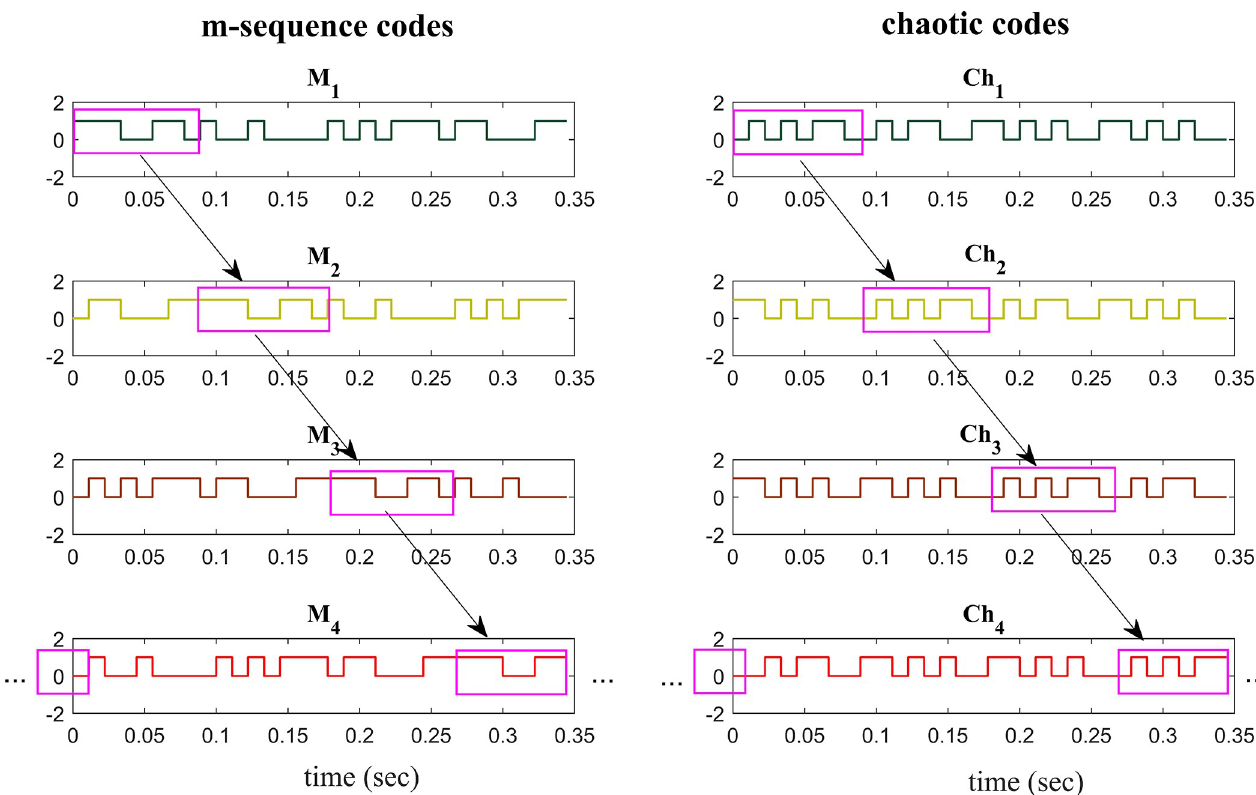
Fig 5. Time domain representation of m-sequence and chaotic codes. Left and right columns show the m-sequence and chaotic codes respectively. M 1 - M 4 and Ch 1 - Ch 4 are the 4 shifted versions of m-sequences and chaotic codes respectively. Each box (shown with pink color) represents temporal shift of 0.088 second (8 bits) ahead with respect to previous one.